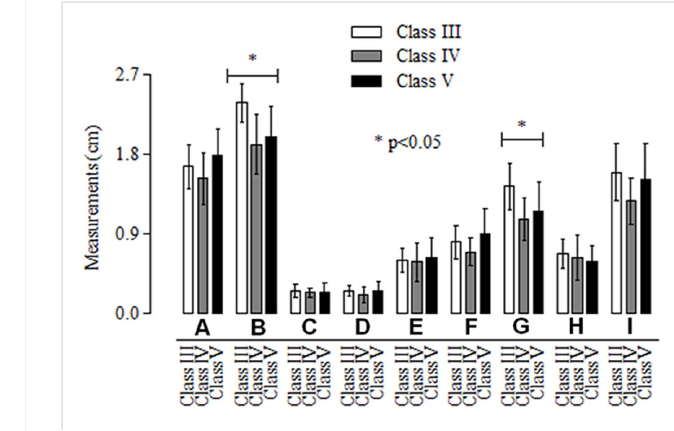
Fig. 2. Stratification of the measurements used in this study according to gender: mandible width (A) and height (B), mandibular canal width (C) and height (D), distance of the mandibular canal to buccal (E), lingual (F), superior (G) and inferior (H) corticals of the mandible and the distance of the mandibular canal to the higher point of the alveolar ridge (I).